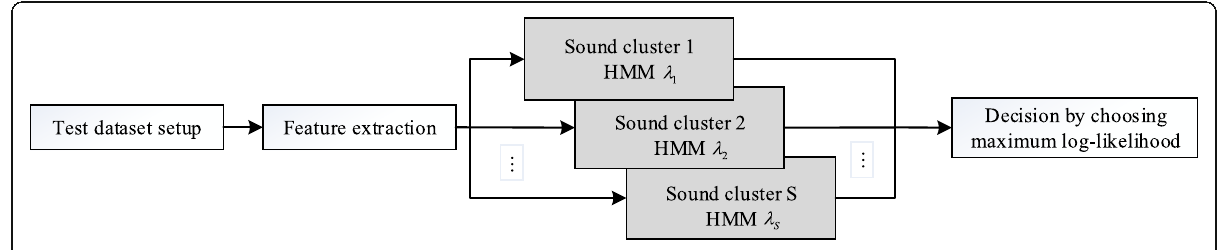
Fig. 14. Block diagram of the testing procedure using HMMs